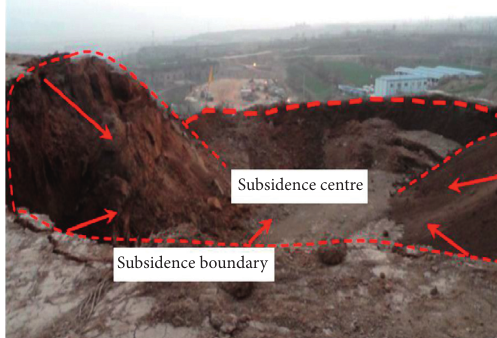
Figure 3: A wide range of surface subsidence.